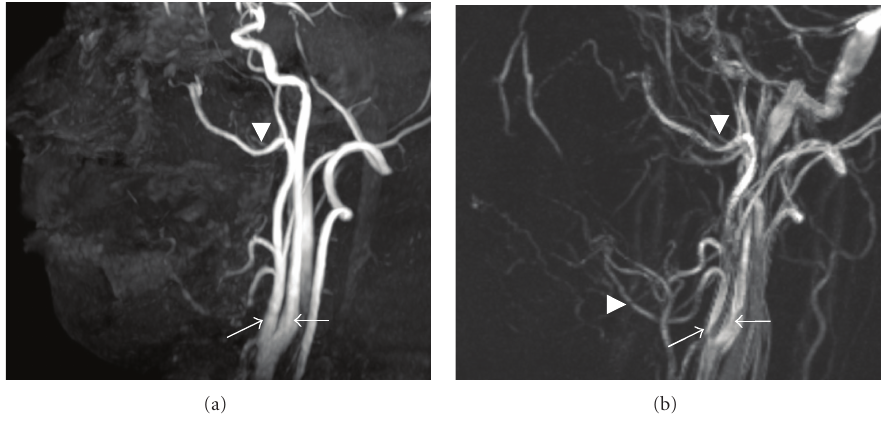
Figure 1: MRA using 3D-TOF (a) and 3D-PC (b) in the oral and maxillofacial regions of a healthy 33-year-old volunteer. (a) On MRA using 3D-TOF, mainly the carotid, maxillary, and facial arteries are shown clearly, but not its branches. The external carotid artery (arrow), internal carotid artery (black arrow), maxillary artery (arrowhead), and facial artery (black arrowhead). Acquisition time was 6 minutes and 39 seconds. (b) On MRA using 3D-PC, the carotid, maxillary, facial, and other peripheral arteries are shown in the same subject as in Figure 1(a). The external carotid artery (arrow), internal carotid artery (black arrow), maxillary artery (arrowhead), and facial artery (black arrowhead). Acquisition time was 10 minutes and 15 seconds.